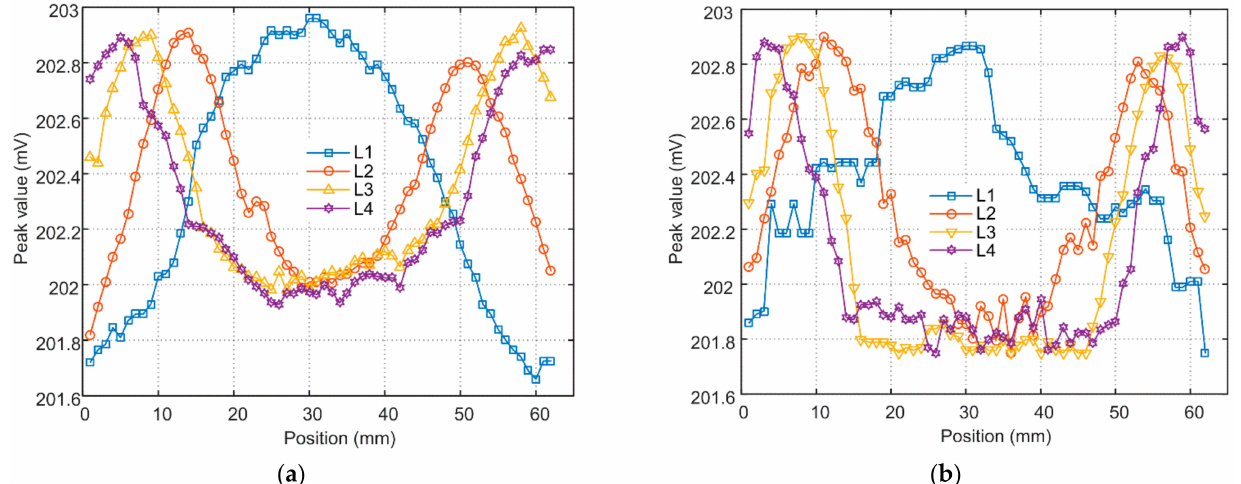
Figure 10. Variation in the experimental signal peak with the probe position when the brazing foil is ( a ) intact and ( b ) incomplete, respectively.